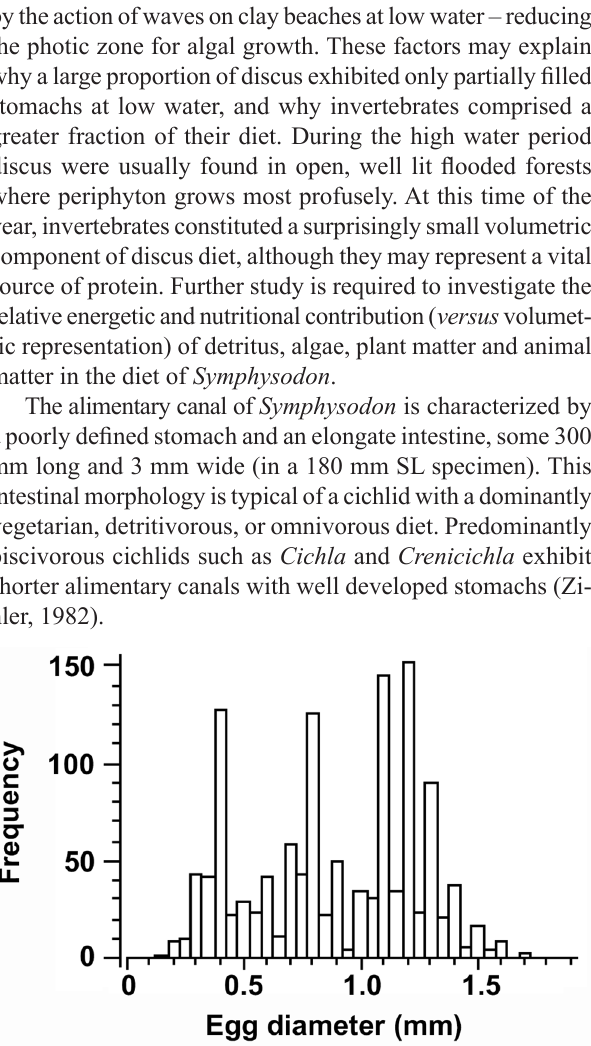
Fig. 12. Histogram showing size distribution of n = 1271 ovules from a pre-spawning (stage 4) female Symphysodon haraldi . Column bin-intervals are 0.05